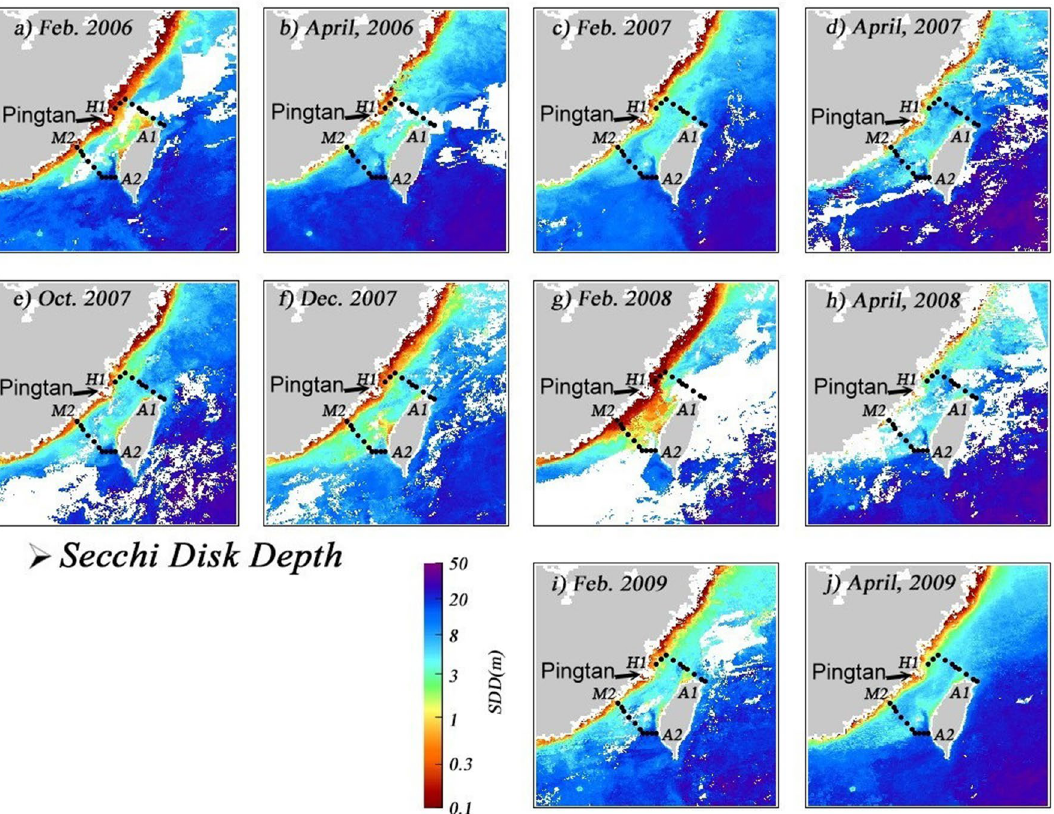
Figure 5. Mean monthly satellite Secchi Disk depth in ( a ) Feb. 2006, ( b ) April 2006, ( c ) Feb. 2007, ( d ) April 2007, ( e ) Oct. 2007, ( f ) Dec. 2007, ( g ) Feb. 2008, ( h ) April 2008, ( i ) Feb. 2009 and ( j ) April 2009 in the vicinity of the study area (map generated by using the m_map toolbox in MATLAB 2019a; https ://www.mathw to the SST image (Fig. 4g) a branch of the high turbidity water veered toward Taiwan and the northward-flowing clean, warm water can no longer be found in the northern Taiwan Strait. By April 2008, however, the high turbidity coverage was greatly reduced in size (Fig. 5h). Although there was much cloud cover so the transparency image was not very good it can still be seen that a jet of the clean water has penetrated northward east of the Penghu Is. and turned westward south of the Changyun Ridge. Traces of low turbidity water can be seen following the depression in the northern Taiwan Strait and extended to the southern ECS. These are in accordance with the satellite SST image (Fig. 4h) and our shipboard observations. Although it is difficult to tell from the difference in color, the water transparency in Feb., and April of 2006, 2007, and 2009 along the coast of China (Fig. 5a,d,i, j) were more than twice that of the Feb. 2008 values (Fig. 5g). It is easy to tell, however, that the eastward penetration of the high turbidity water found in Feb. 2008 was absent in Feb. 2006, 2007, and 2009. Again, this is perhaps because of the stronger northeast monsoon in the La Niña year of 2008. Figure 6a–j shows the sea surface wind in the study area. Without going into details it is immediately apparent that the northeast winds were the strongest in Feb. 2008 compared with those found in Oct. 2007, Dec. 2007 and April 2008. The Feb. 2008 winds were also the highest compared with the same period in the non-La Niña years of 2006, 2007, and 2009. In addition, we also related the Oceanic Niño Index (ONI; Fig. 7a) with the average v vector of northeast (Fig. 7b) winds between Nov. and April from 1993 to 2012. The ONI was very negative, sign- aling La Niña, in the fall-spring of 2007/2008. Correspondingly, the northeast winds were strong as indicated by the negative satellite wind anomaly. Figure 7c presents the monthly v vector of the satellite wind anomaly with the monthly ONI. The correlation is highly positive with a p < 0.001. Figure 8a–j presents the monthly mean SLA images in the vicinity of the study area. When the northeast wind is significant (Fig. 7a,e–g), the Ekman transport induced by the wind generally results in a higher SLA to the west of the Taiwan Strait (Fig. 8a,e,f). In Feb. 2008, however, the sea surface in the central Taiwan Strait tilted downward toward the southeast, indicating a cross-strait flow from the China coast in the northwest to the Penghu Is. in the southeast (Fig. 8g). This is consistent with the SST image in Fig. 4g, as described before. On the other hand, when the monsoon is weak, as in April of 2006, 2007, 2008 and 2009 higher SLA is near the eastern Taiwan Strait which implies a northward flow in the Strait (Fig. 8b,d,h,j). Figure 9 shows the mean AVISO geostrophic current in the study area. It is apparent that the currents were much stronger in the La Niña Feb. of 2008 compared to those in 2006, 2007 and 2009.